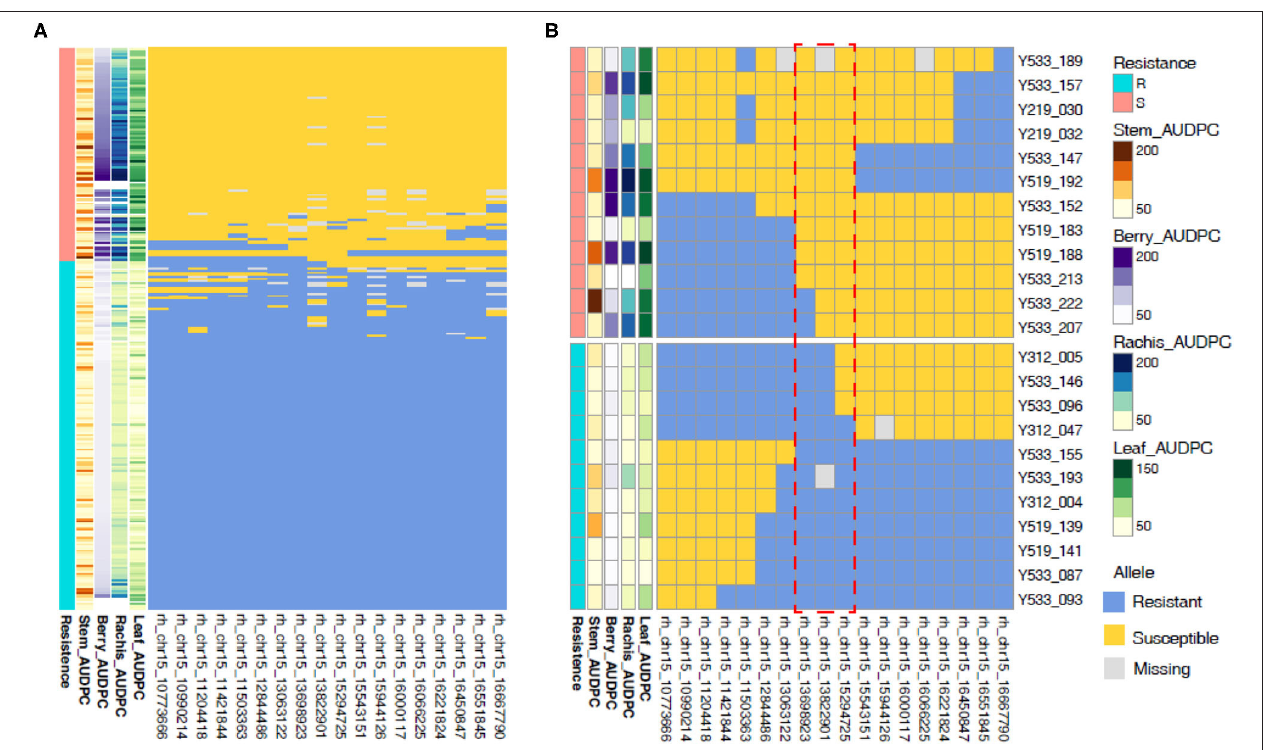
FIGURE 6 | Recombinations within the REN11 resistance QTL define the locus to 13.7–15.3 Mbp on Chr 15. Resistance was categorized subjectively based on the multi-tissue area under the disease progress curve (AUDPC) phenotypes from 2016 (A) across all samples, then (B) focusing on samples with recombinations in the REN11 resistance QTL. Each row represents a different vine, and columns represent a phenotype or rhAmpSeq marker ordered by physical position. The red dotted box indicates the recombinations that define the